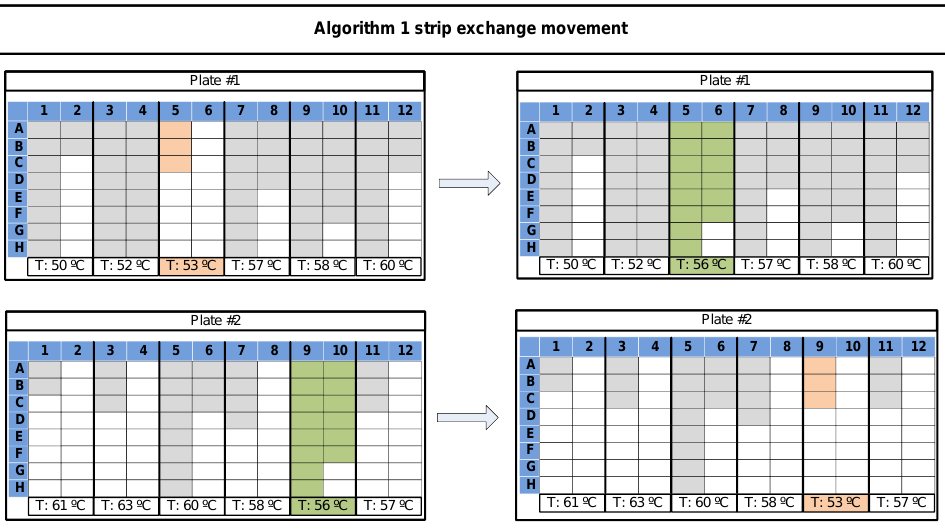
Figure 2. Algorithm 1 strip exchange movement